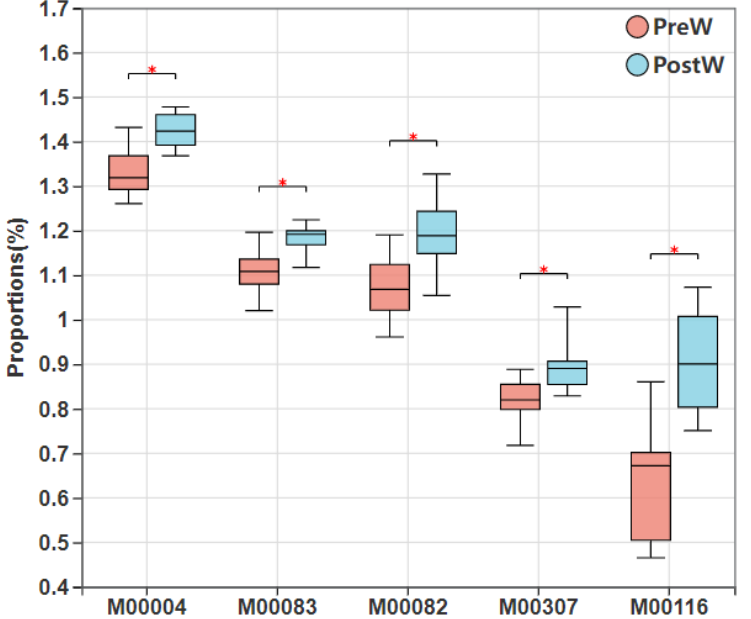
Figure 9. Comparison of enriched KEGG metabolic pathways of preweaning and postweaning donkeys. KEGG, Kyoto Encyclopedia of Genes and Genomes; PreW, preweaning group; PostW, postweaning group; ko00620, pyruvate metabolism; ko00010, glycolysis/gluconeogenesis; ko00520, amino sugar and nucleotide sugar metabolism; ko01210, 2-oxocarboxylic acid metabolism; ko00250, alanine, aspartate, and glutamate metabolism; ko00400, phenylalanine, tyrosine, and tryptophan biosynthesis; ko00030, pentose phosphate pathway; ko00061, fatty acid biosynthesis; ko00051, fructose and mannose metabolism; *, p < 0.05; **, p < 0.01.